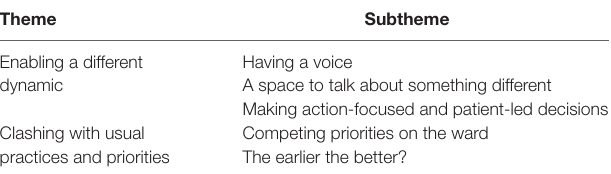
TABLE 3 | Themes and